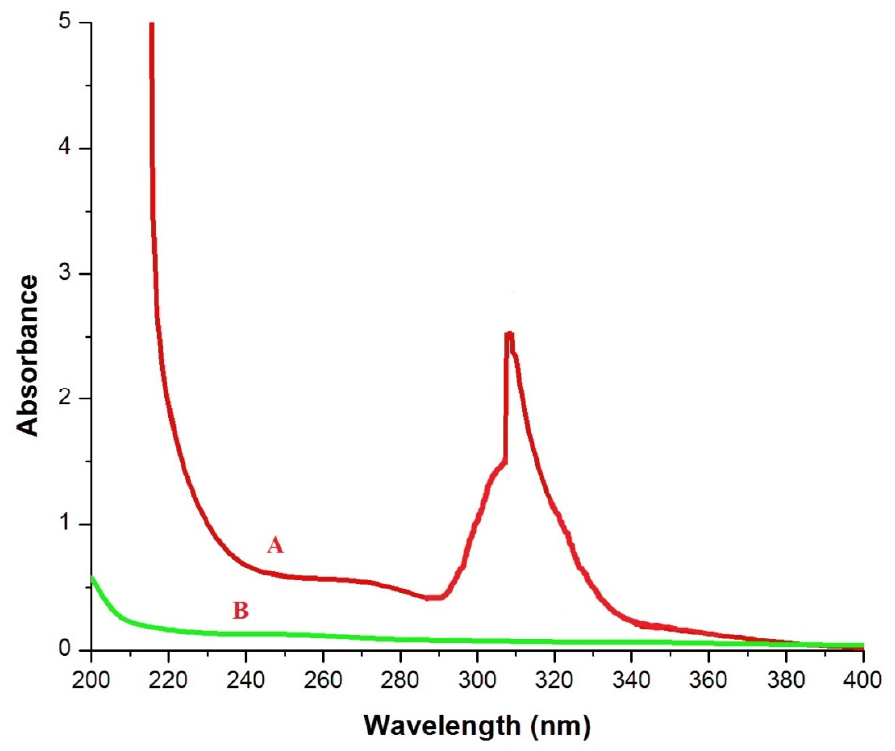
Figure 1. UV spectra, where A = n Si and B = extracted lignin from coir pith. (Optical property was assessed.)